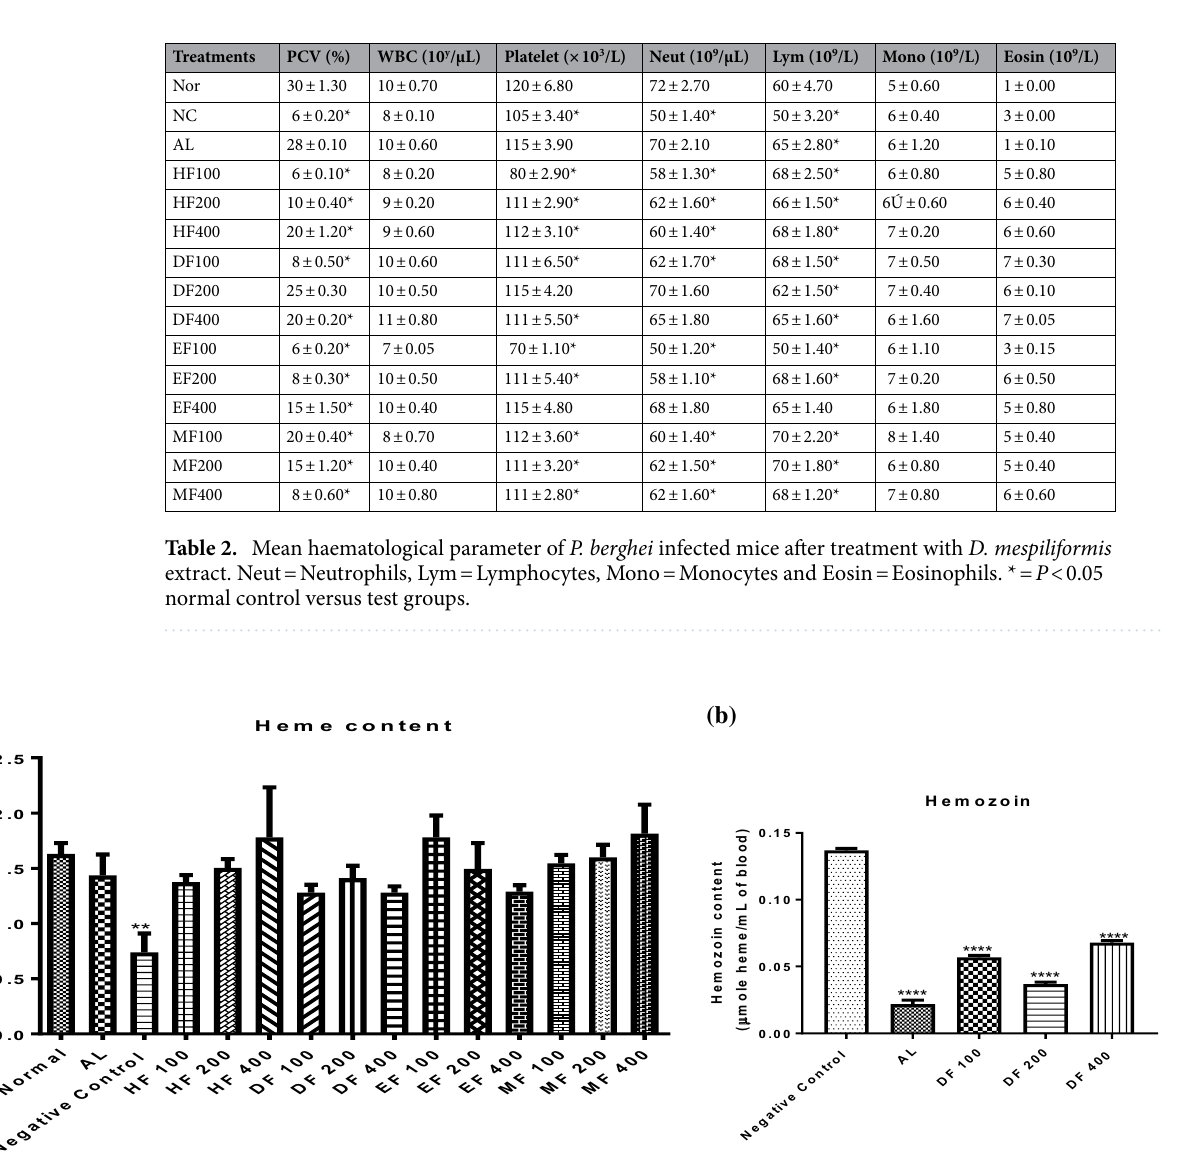
Figure 1. Heme ( a ) and hemozoin ( b ) contents of mice treated with fractions of D. mespiliformis . ** = P < 0.01 vs normal control in ( a ); **** = P < 0.0001 vs negative control in ( b